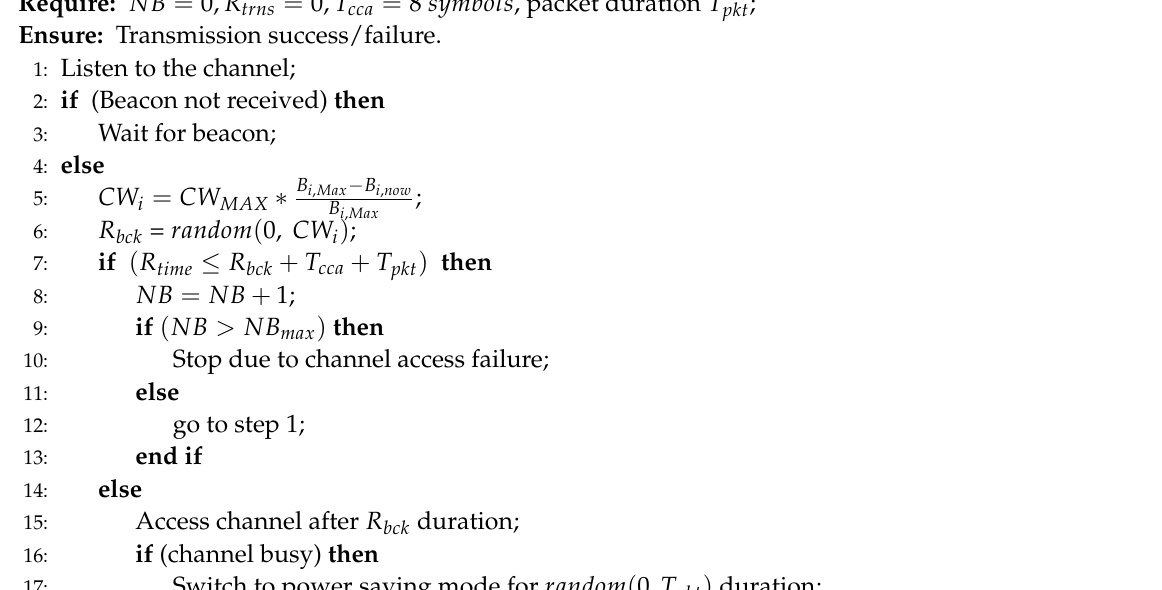
Algorithm 1 The modified CSMA/CA